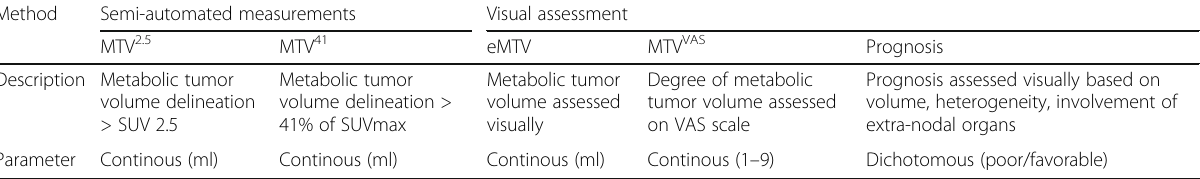
Table 1 Semi-automated methods and visual assessment of tumor volume and prognosis